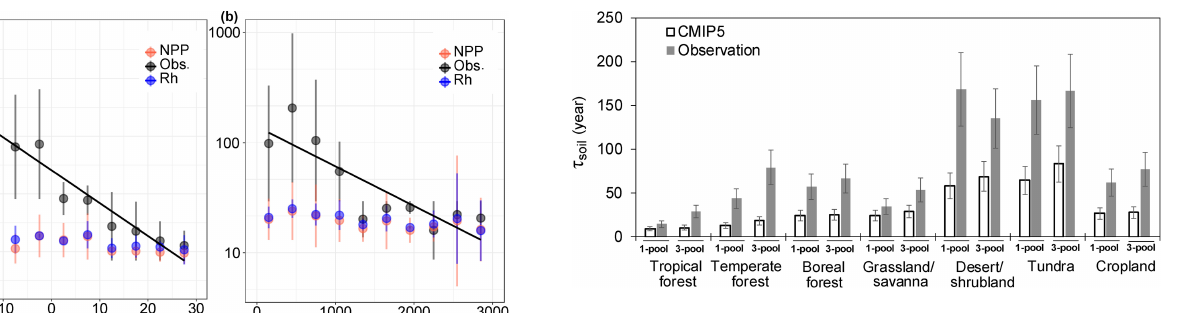
Figure 4. The SOC transit time ( τ soil ) calculated from the one- and three-pool models under the steady-state